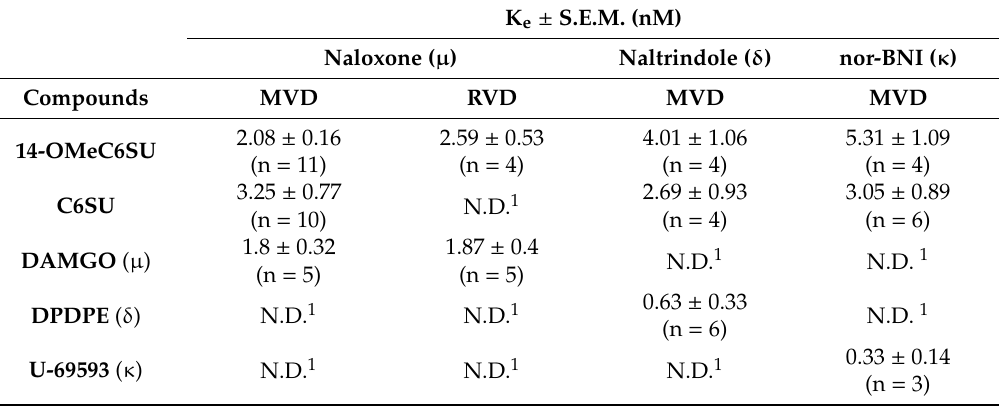
Table 5. The opioid receptor selectivity of 14-OMeC6SU in electrically evoked contractions of MVD and RVD bioassays compared to C6SU, indicated by the K e value of selective opioid antagonists. Reference opioid agonists were also measured for control.